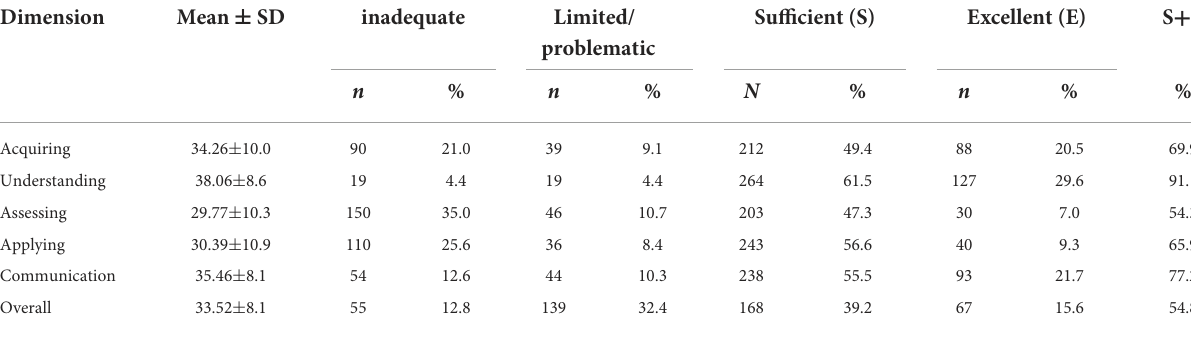
TABLE 3 The scores of five dimensions with overall and the distribution of health literacy levels in MMHLQ. Dimension